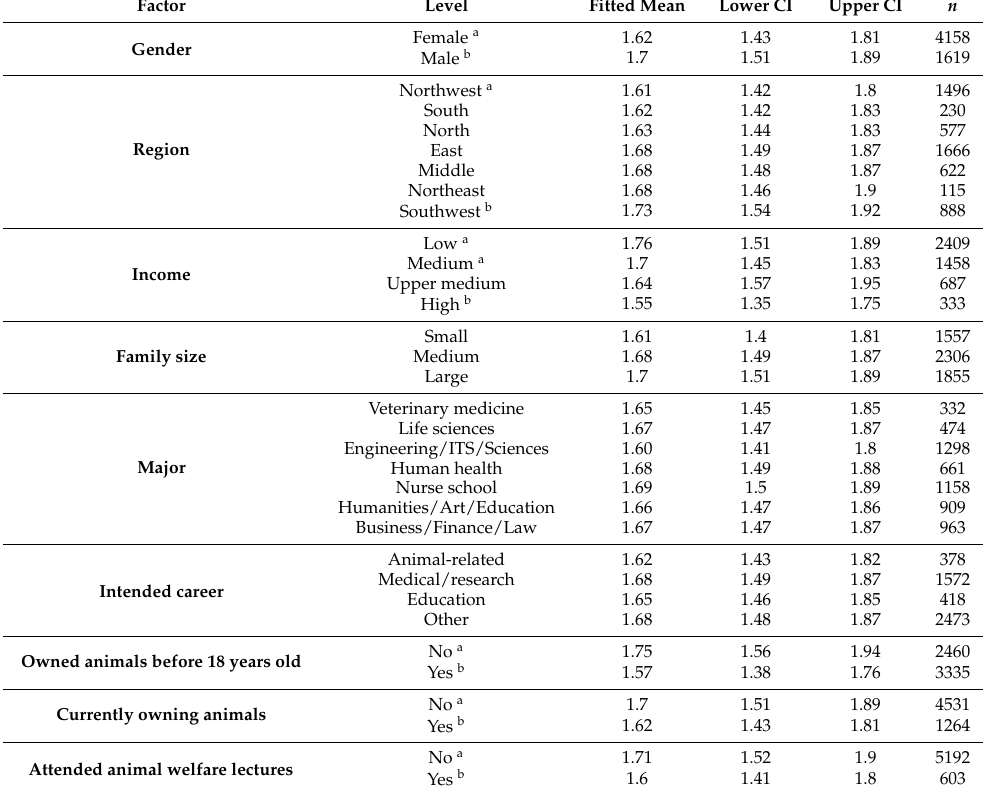
Table 4. Means and 95% confidence intervals (CIs) of scores towards the Five Freedoms model according to the students’ characteristics. Within each factor, categories that have different lower-case letters differ significantly (Wald chi-squared tests with Bonferroni correction). n = number of students. Factor Level Fitted Mean Lower